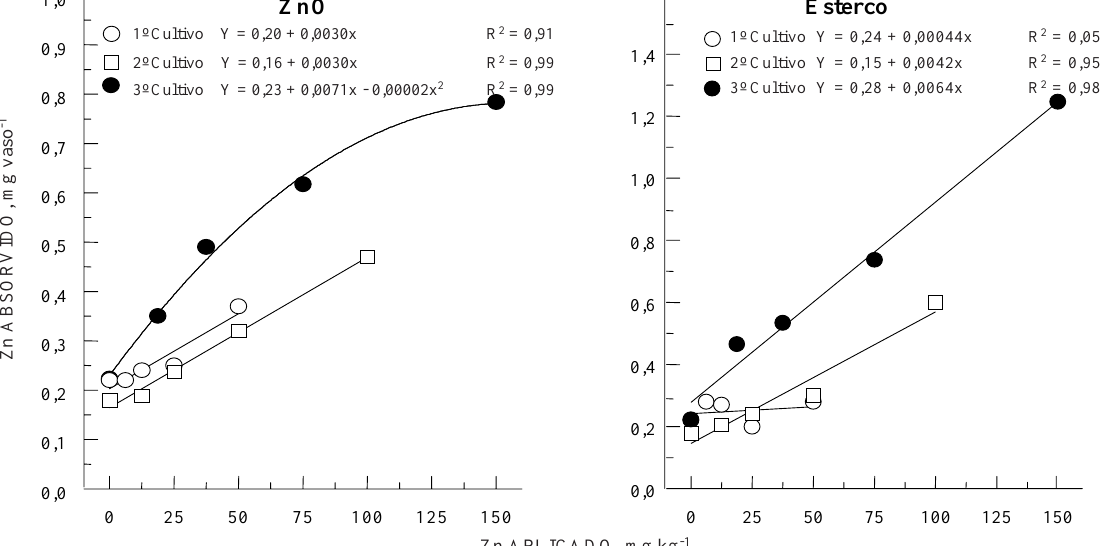
Figura 3. Quantidades de Zn absorvido em cada cultivo de milho, considerando a aplicação de quantidades crescentes e cumulativas de Zn na forma de esterco de suínos ou de ZnO. Média de três